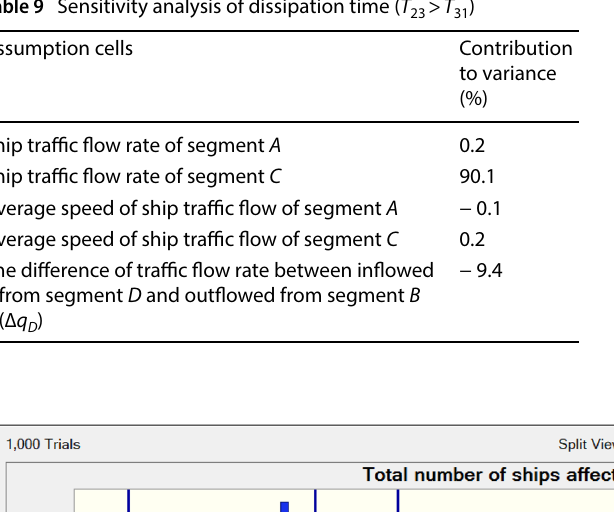
Table 9 Sensitivity analysis of dissipation time ( T